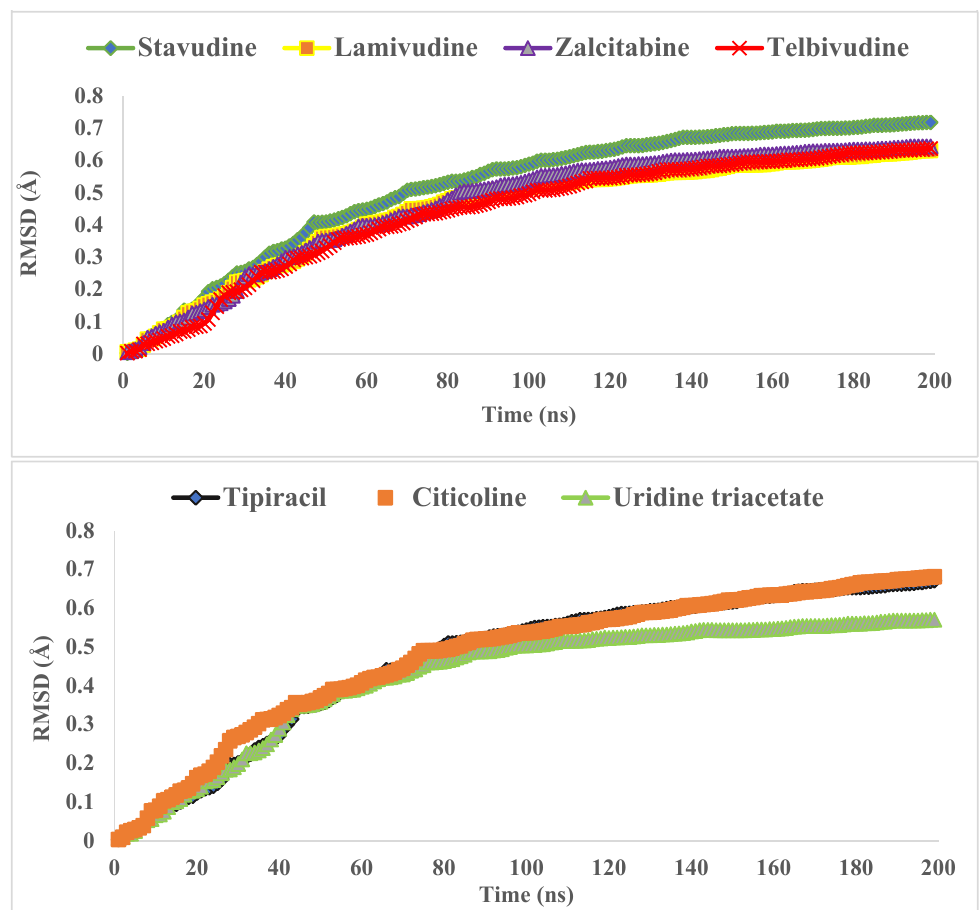
Molecules 2021 , 26 , x FOR PEER REVIEW Figure 3. The RMSD values of the simulated PP-3CL pro complexes throughout the 200 ns production runs.